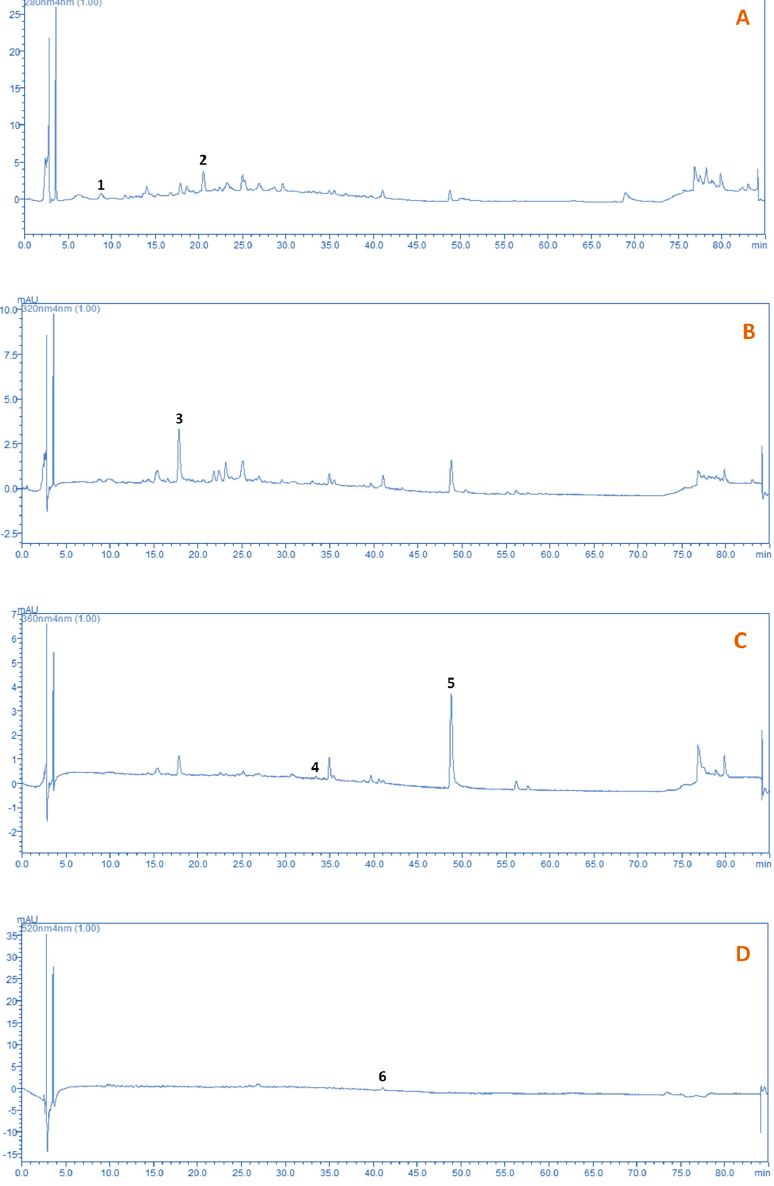
Figure 8. HPLC traces recorded at 280 ( A ), 320 ( B ), 365 ( C ) and 520 nm ( D ), of the extract prepared using β -CD. Extractions with β -CD were performed under optimized conditions ( C CD = 1.5%, t us = 30 min, R L/S = 90 mL g − 1 ), under stirring at 900 rpm, for 180 min. Peak assignment: 1, gallic acid; 2, catechin; 3, caftaric acid; 4, rutin; 5, quercetin; 6, malvidin 3- O -glucoside p -coumarate.